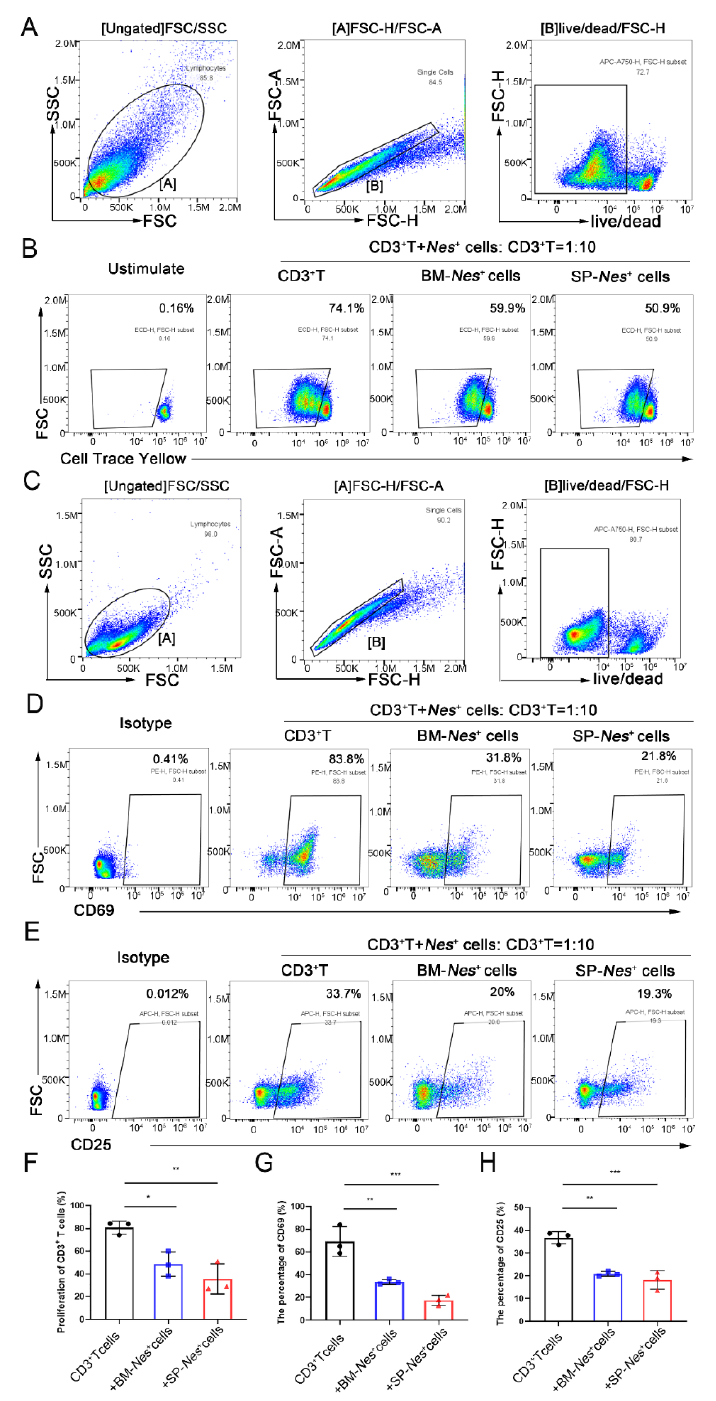
Figure 5. Immunosuppressive properties of Nes -GFP + cells (T cells proliferation and activation suppression assay): ( A ) Gating strategy for the evaluation of T cells proliferation; ( B ) Nes -GFP + cells were cocultured with sorted CD3 + T cells, and the percentage of T cells proliferation was evaluated by flow cytometry. Representative plots of three independent experiments. ( C ) Gating strategy for the evaluation of T cells activation markers (CD69 and CD25); ( D , E ) Nes -GFP + cells were cocultured with sorted CD3 + T cells, and the percentage of CD69 and CD25 was evaluated by flow cytometry. Representative plots of three independent experiments; ( F – H ) Bar graphs showed the inhibition rate of T cells proliferation and activation after coculture with Nes -GFP + cells. Data represent mean values ± SD of three independent experiments. * p < 0.05, ** p < 0.01, *** p <